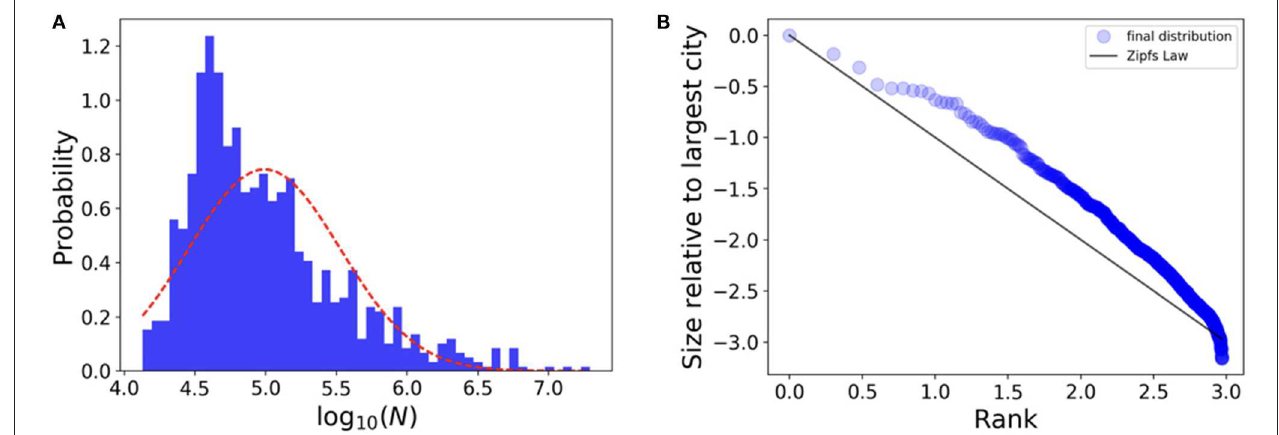
FIGURE 1 | The city size distribution of Metropolitan Areas in the USA in 2010. (A) Histogram of city sizes (red dashed line is lognormal distribution fit); (B) Rank-size rule [black line is Equation (1)]. We see that in the USA the rank size rule approximately describes the relative distribution of large cities but fails to account for an overabundance and then deficit of progressively smaller towns. Data is available online at the US Census Bureau, Website: https://www.census.gov/programs-